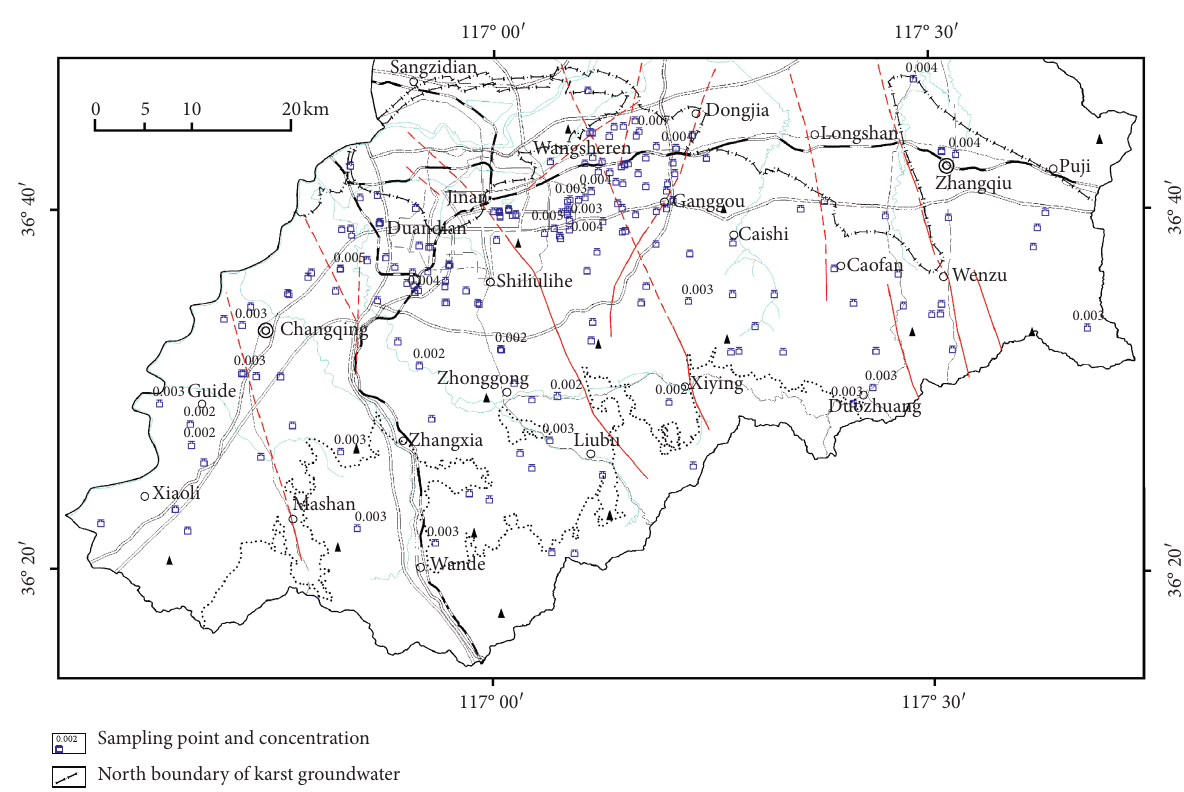
Figure 3: Distribution of Pb concentrations in fractured karst